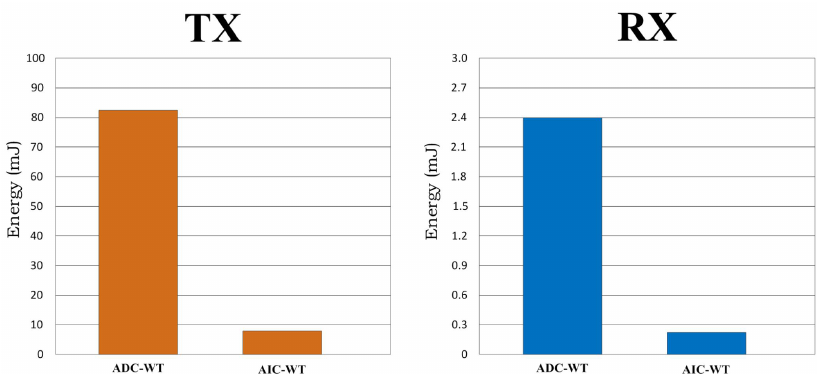
Figure 19. Comparison of power consumption between ADC and AIC system in wireless